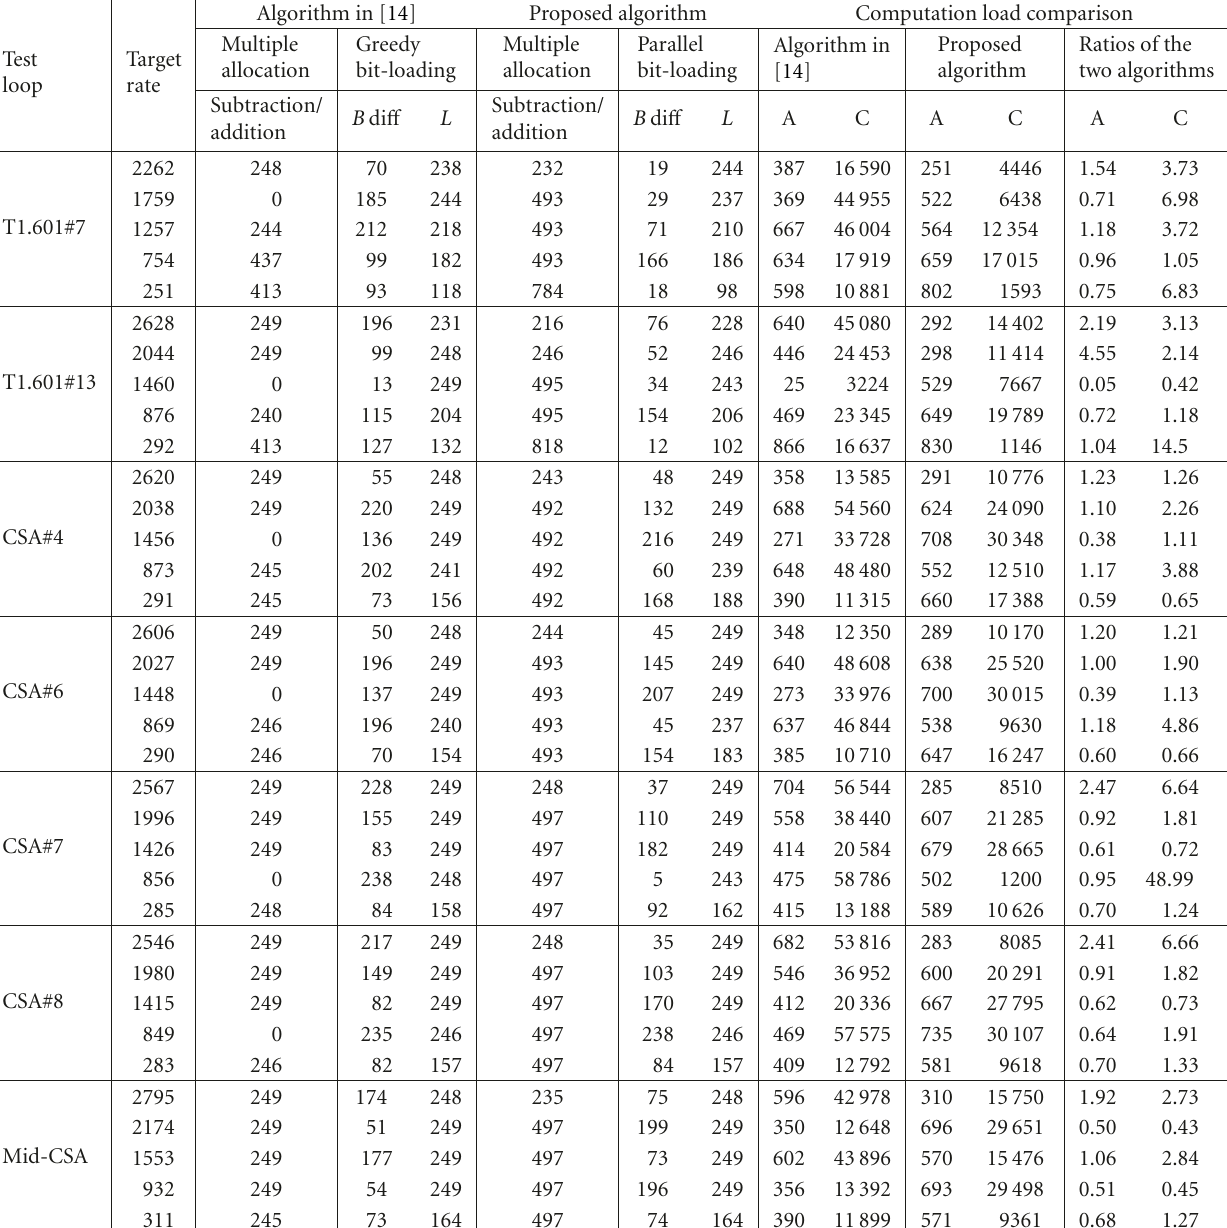
Table 2: Simulation results showing the computation load of the proposed algorithm and that of existing